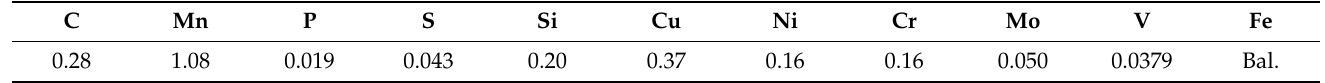
Table 1. Elemental composition of carbon steel rebar specimens